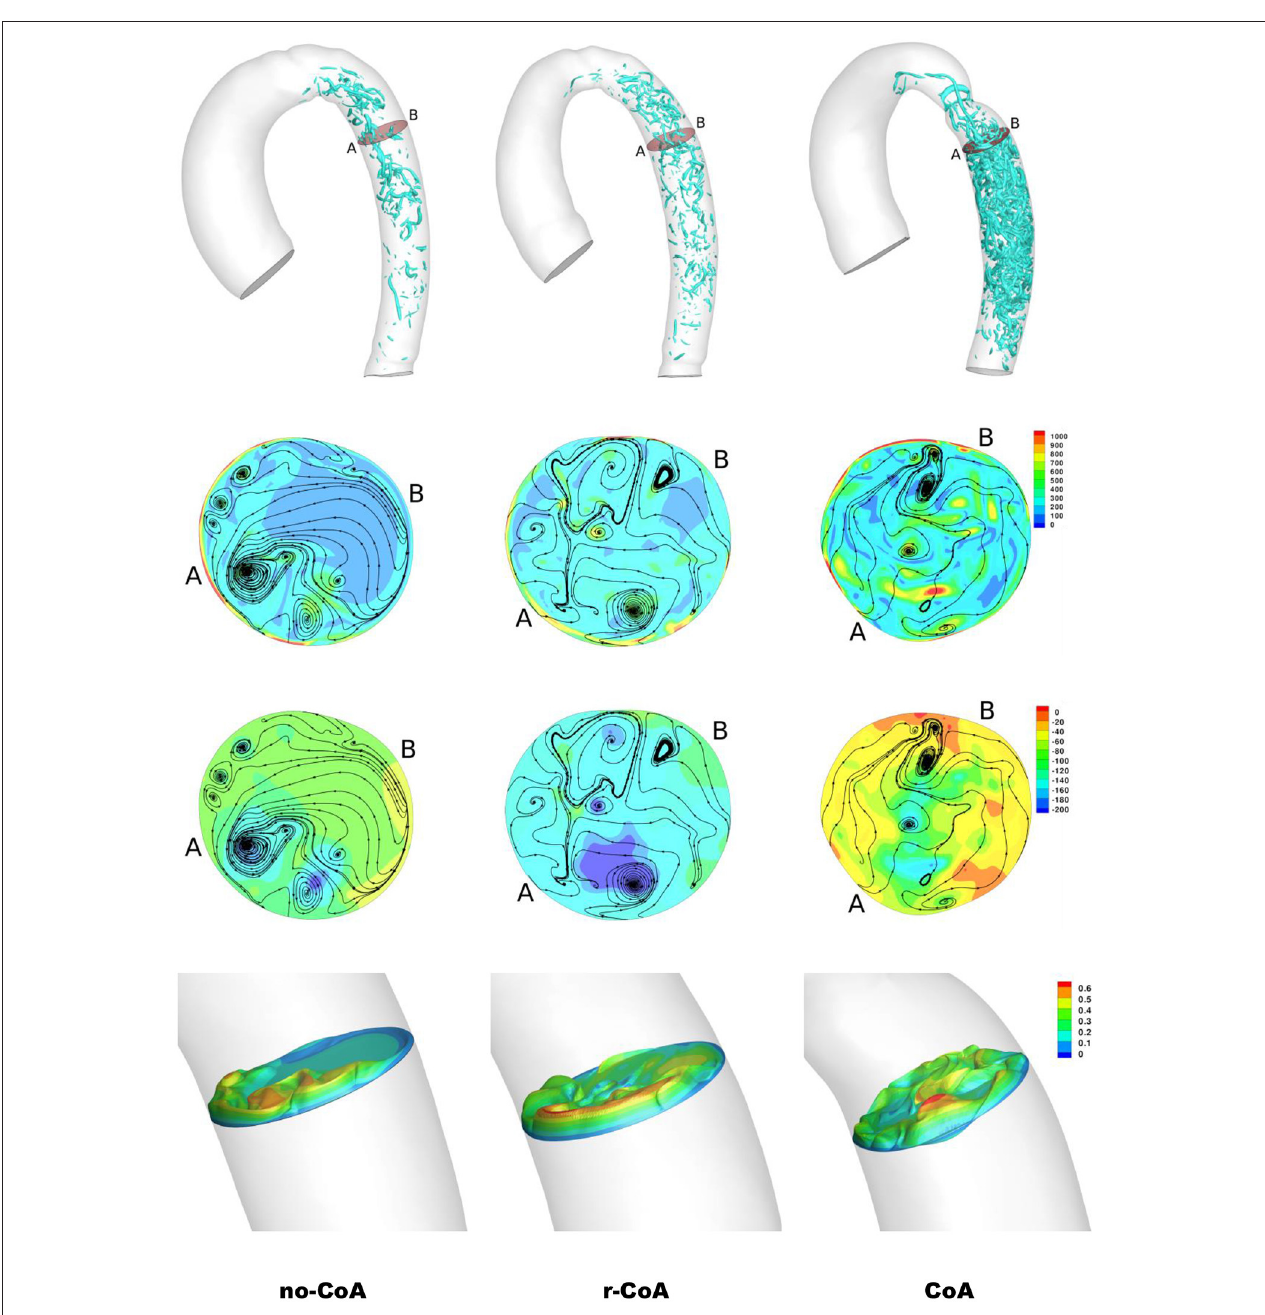
FIGURE 5 | Result of the simulations at end systole. First row: vortical structure by iso-surface of λ 2 = − 30,000 in the descending aorta. Second row: contour of vorticity (/s) along with velocity streamlines. Third row: contour of pressure along with velocity streamlines. Fourth row: velocity cross-section (m/s). The cross-sections are identified in the first